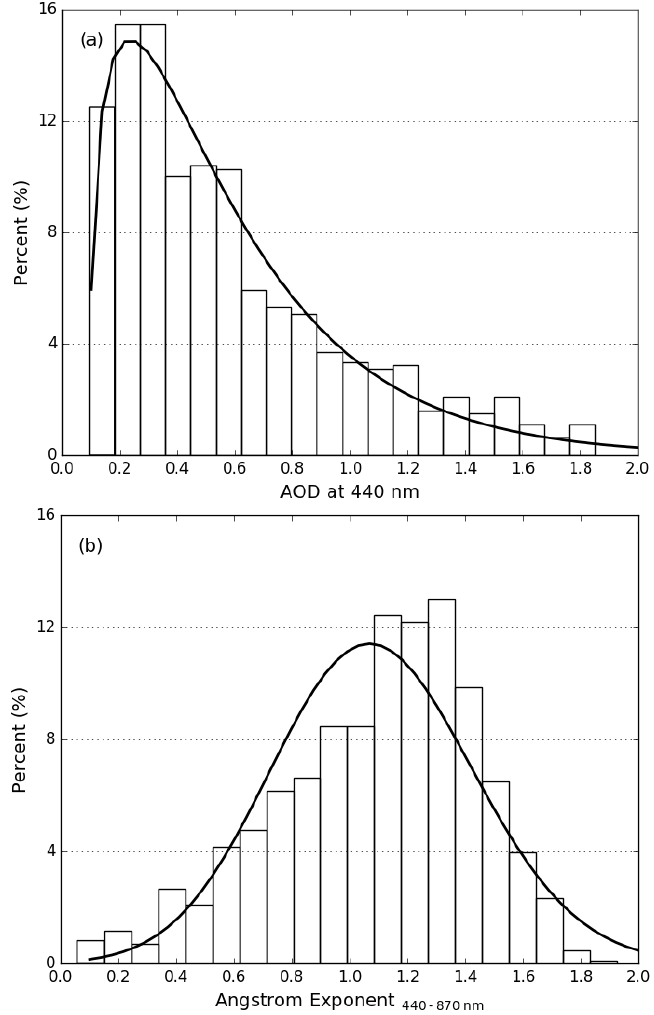
Figure 5. Frequency of the daily values of the ( a ) AOD and ( b ) Ångström exponent at Dalian monitoring station.